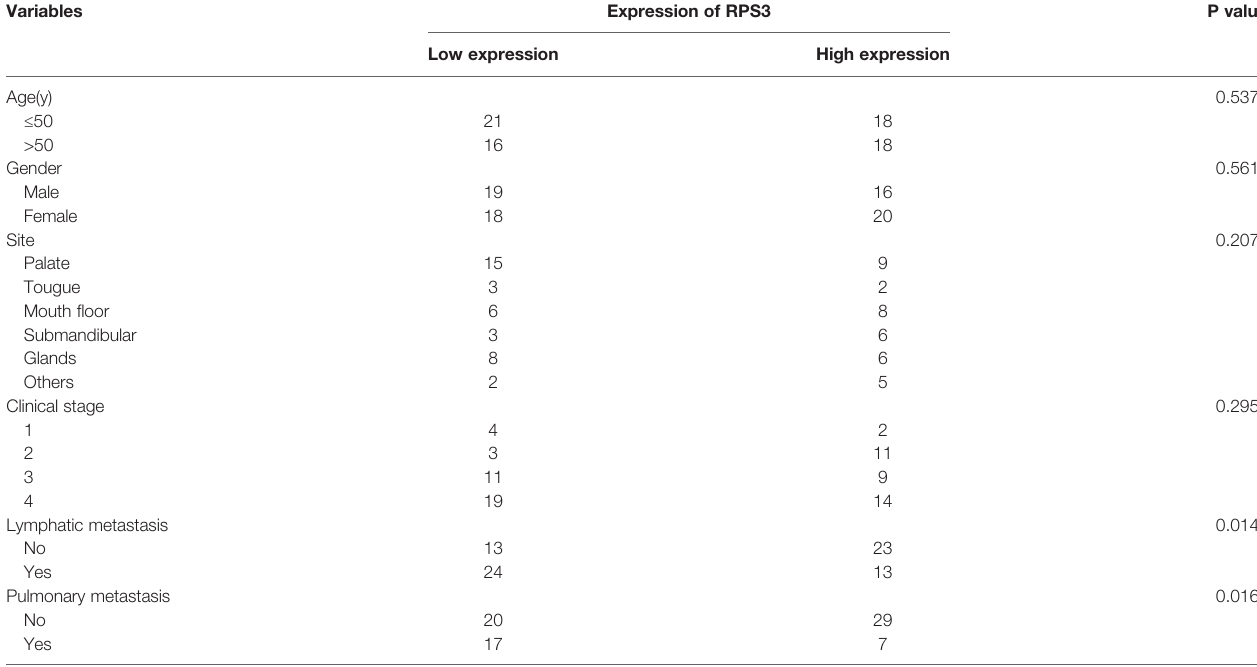
TABLE 3 | Association of RPS3 expression with the features of ACC patients.